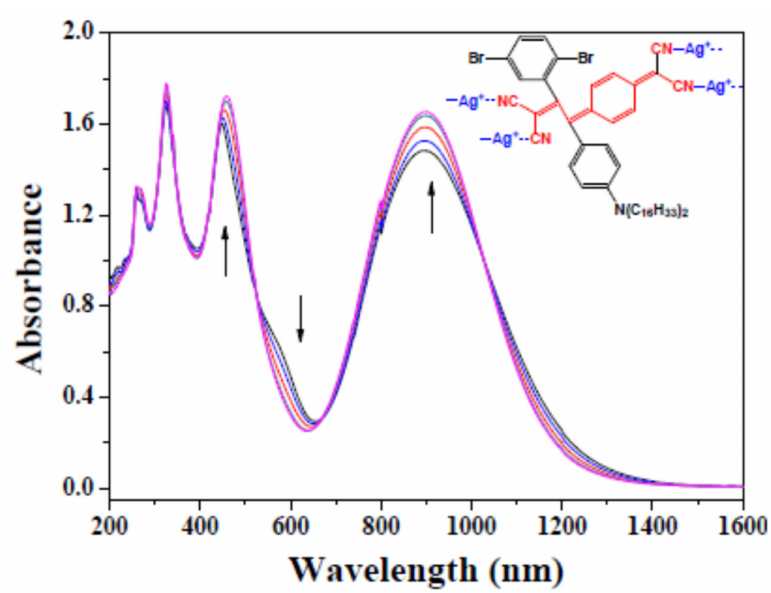
Figure 5. UV-Vis–NIR spectral changes of the sensors with Ag + (A-F4-TCNQ/DMF: 1 × 10 − 4 mol/L; AgSO 3 CF 3 /DMF: 0.2 mol/L, titration dose: 2 µ L each, rt). Inset: Intermolecular interaction between A-F4-TCNQ and Ag +